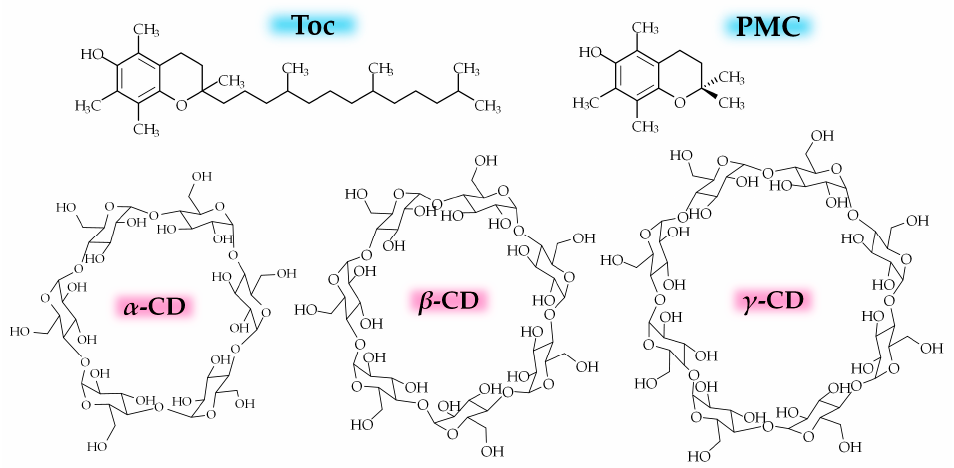
Figure 1. Molecular structures of (blue) a vitamin E ( α -Tocopherol; Toc), a water-soluble artificial Toc analogue, 2,2,5,7,8-pentamethyl-6-chromanol (PMC), and (pink) natural cyclodextrin (CD) compounds used in this study.